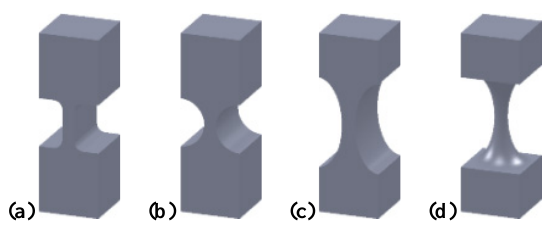
Figure 2. Notch-type flexures with lumped compliance. The notch profile is (a) rectangular corner-filleted, (b) circular, (c) parabolic, or (d)